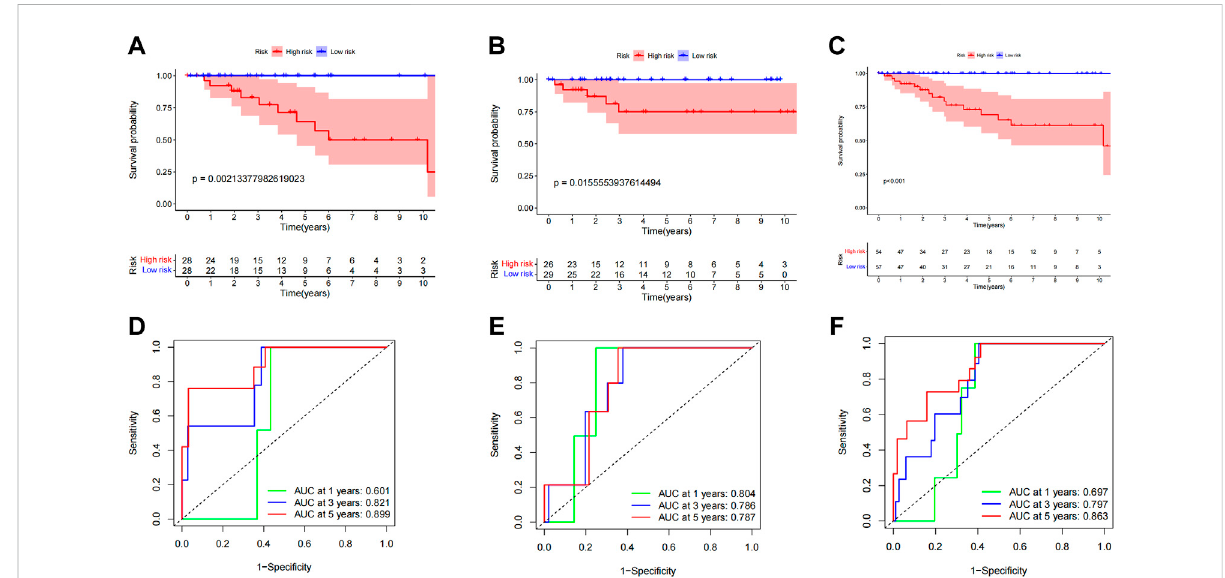
FIGURE 12 Evaluate the predictive value of CCCH-type zinc fi nger-associated lncRNA signaling for DFS. (A) Kaplan-Meier survival curves for the entire dataset. (B) Kaplan Meier survival curves for the fi rst cohort of patients. (C) Kaplan-Meier survival curves for the second cohort. (D) ROC curves and AUCs for the 1-, 3-, and 5-year survival rates of the entire dataset. (E) ROC curves and AUCs for the1-, 3-, and 5-year survival rates of the fi rst cohort of patients. (F) ROC curves and AUCs for the1-, 3-, and 5-year survival rates of thesecond cohort of patients. lncRNAs, long-chainnon-coding RNAs; DFS, disease-free survival; ROC: receiver operating characteristic; AUC, area under the